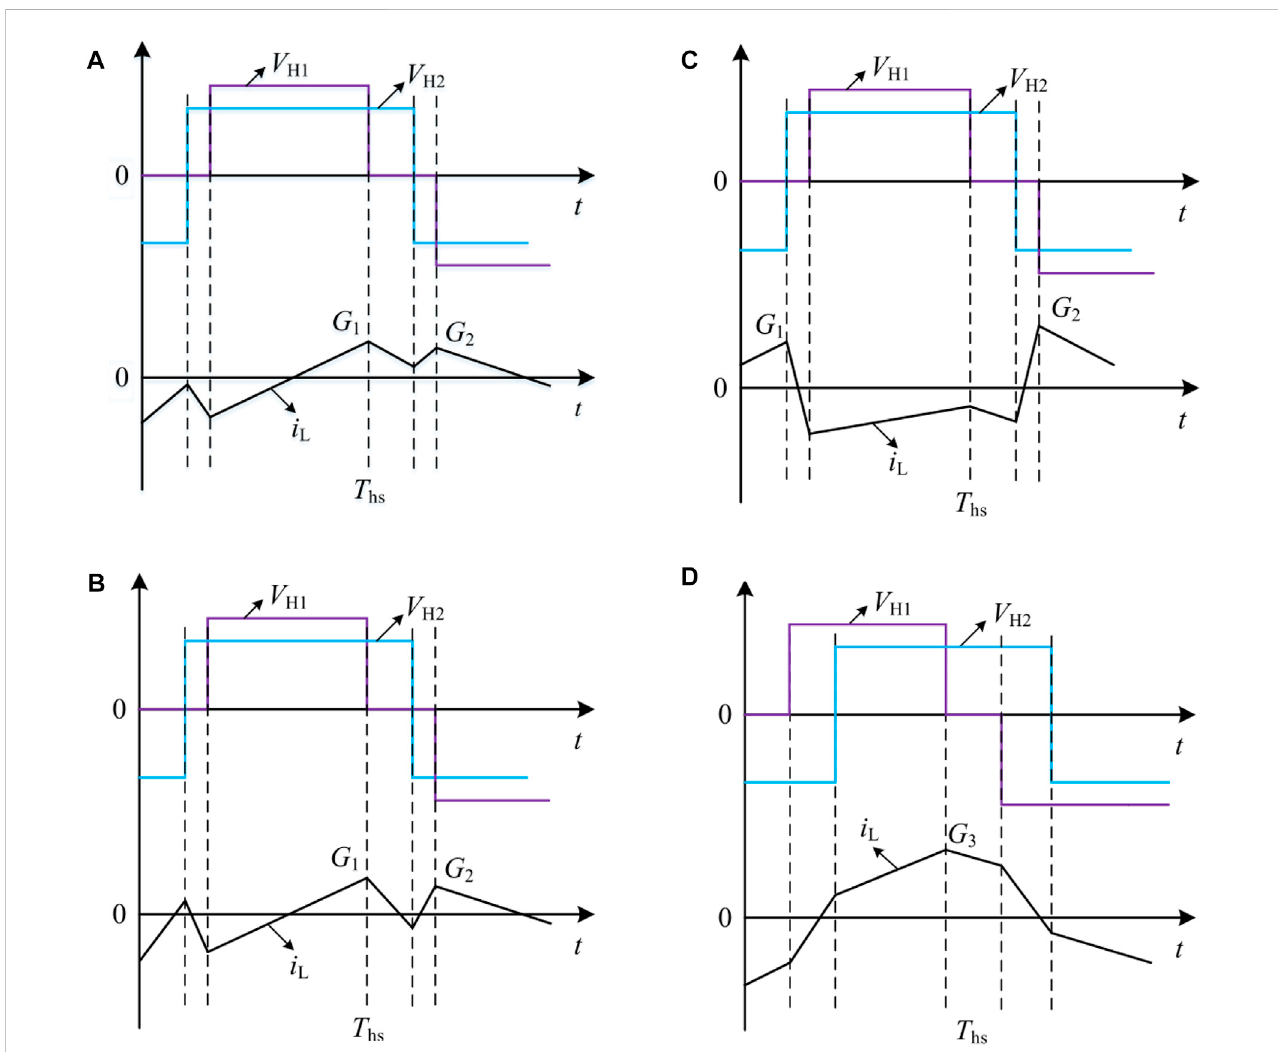
FIGURE 3 The operation waveform for EPS modulation of DAB converter: (A) EPS mode A; (B) EPS mode B; (C) EPS mode C; (D) EPS mode